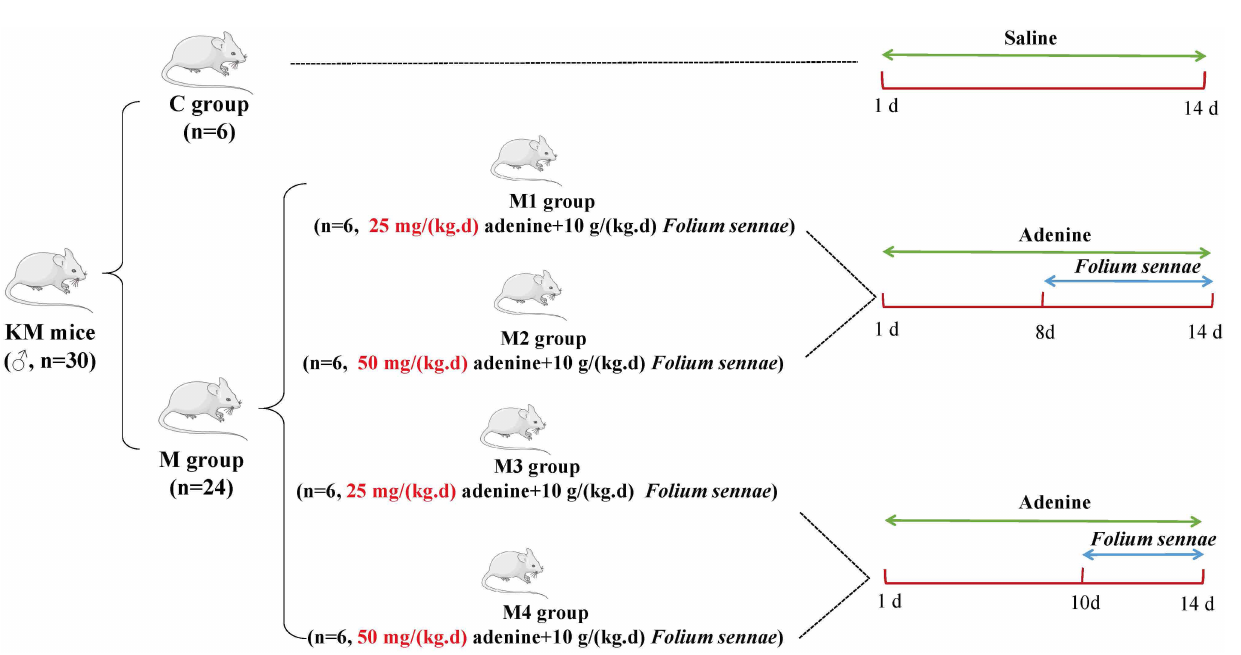
Figure 1. Modeling flow chart of adenine combined with Folium sennae